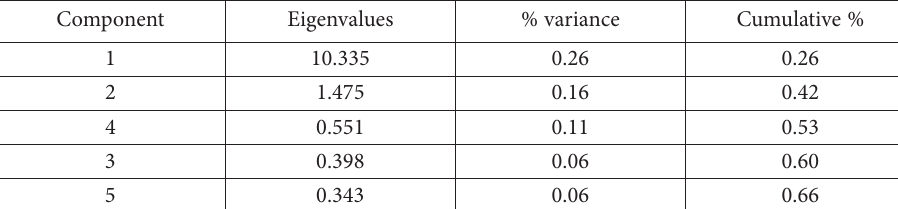
Table 1. Initial eigenvalues (source: own research) Component Eigenvalues % variance Cumulative % 1